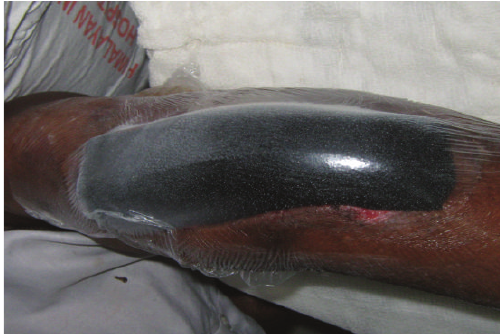
Figure 2: Sterile drape was applied covering the foam and 2-3 cm of the surrounding